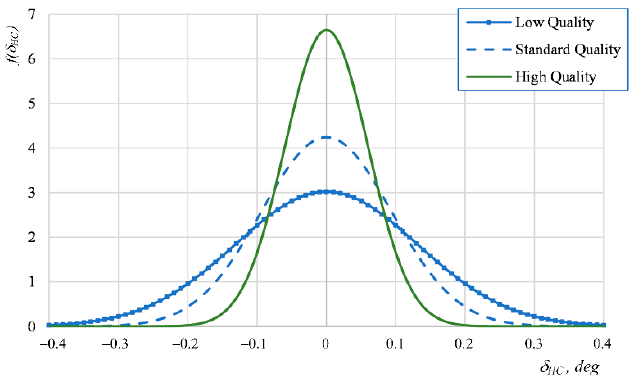
Figure 6. PDFs for warhead-to-chamber manufacturing error δ HC angles.